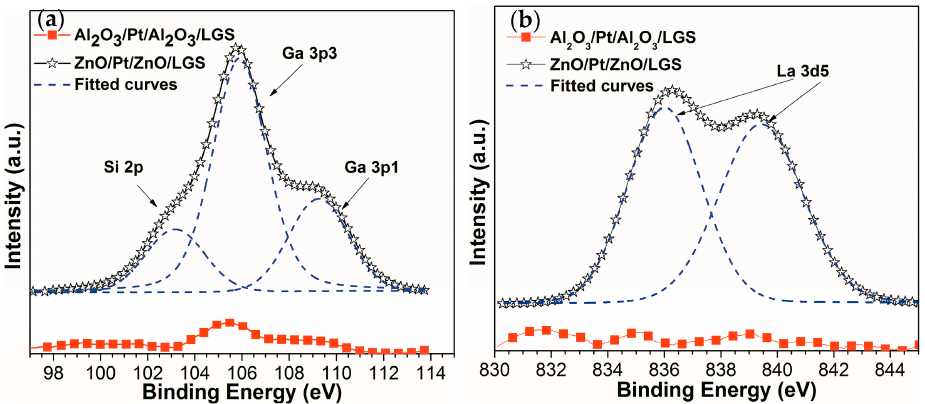
Figure 1. XPS ( X-ray photoelectron spectroscopy ) spectra of ( a ) Ga 3p, Si 2p and ( b ) La 3d5 for Figure 1. XPS (X-ray photoelectron spectroscopy) spectra of ( a ) Ga 3p, Si 2p and ( b ) La 3d5 for ZnO/Pt/ZnO/LGS and Al 2 O 3 /Pt/Al 2 O 3 /LGS samples after annealing at 1000 °C for 1 h. ZnO/Pt/ZnO/LGS and Al 2 O 3 /Pt/Al 2 O 3 /LGS samples after annealing at 1000 ◦ C for 1